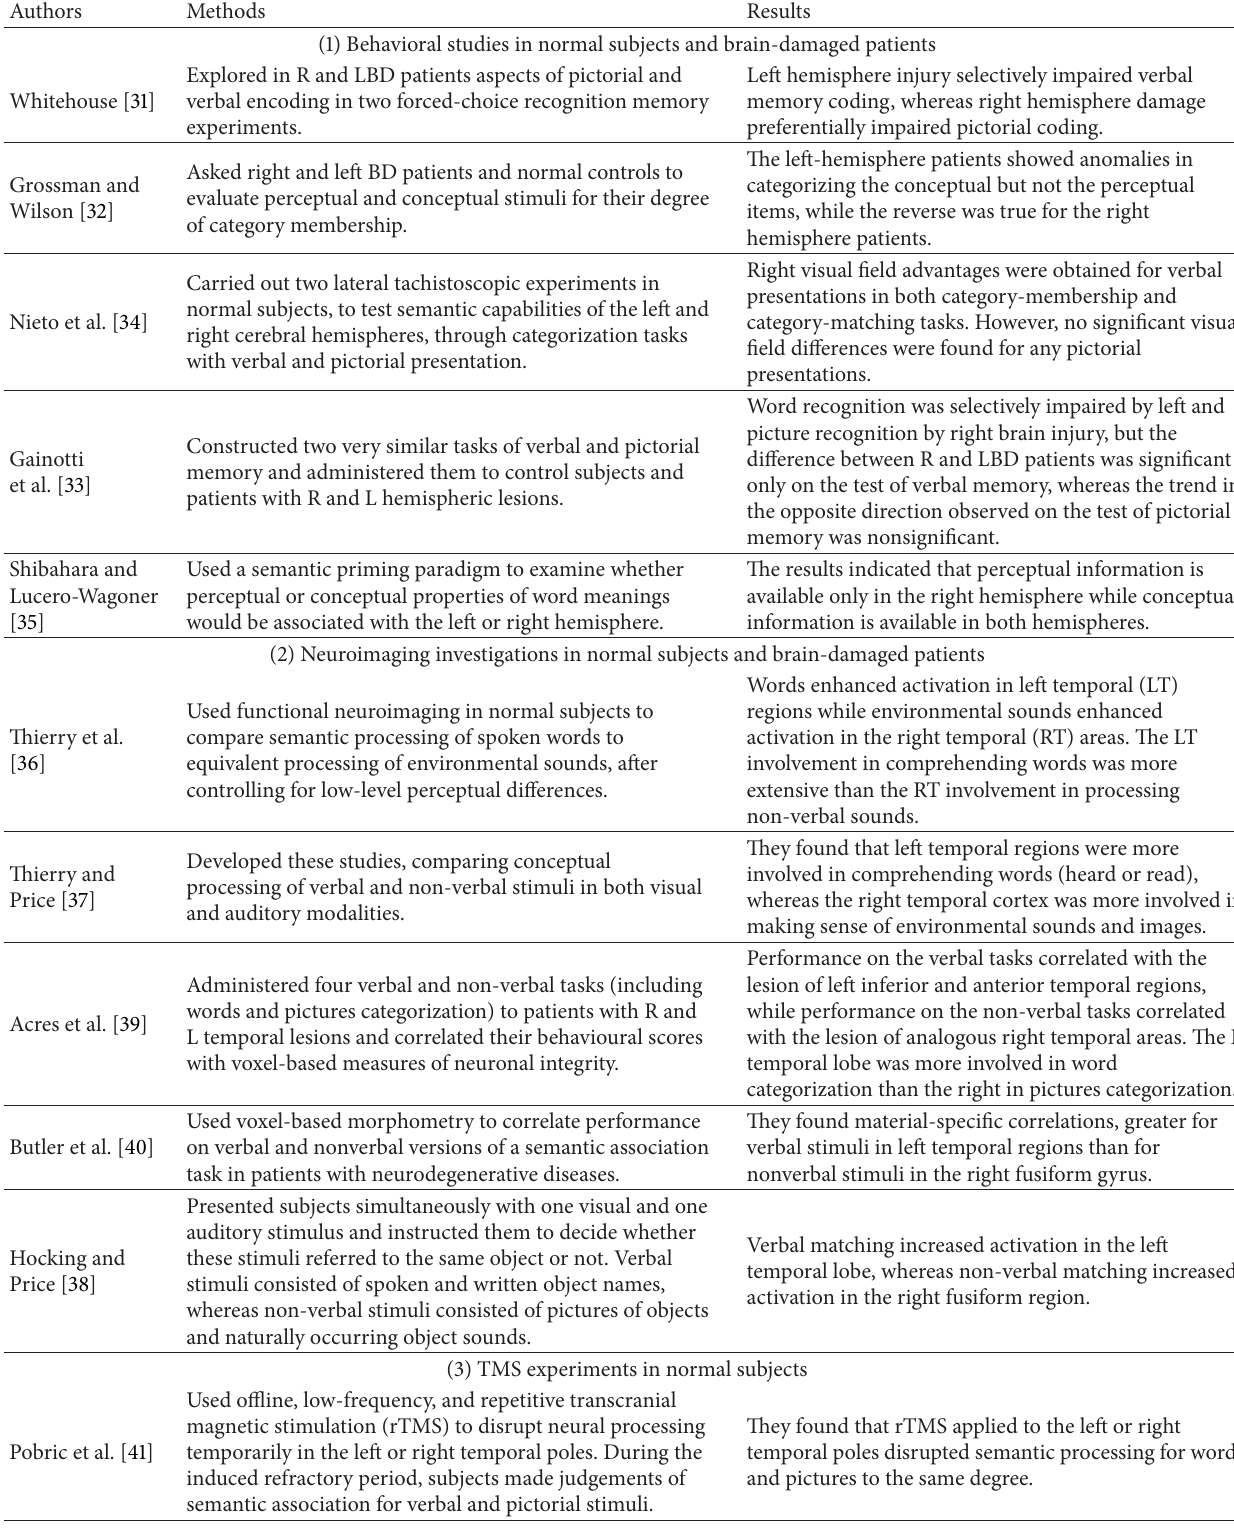
Table 1: Results of neuropsychological investigations that have compared memory or conceptual disorders observed with pictorial and verbal material in right and left brain-damaged patients and of experiments conducted with similar material to test the semantic capabilities of the left and right hemisphere in normal